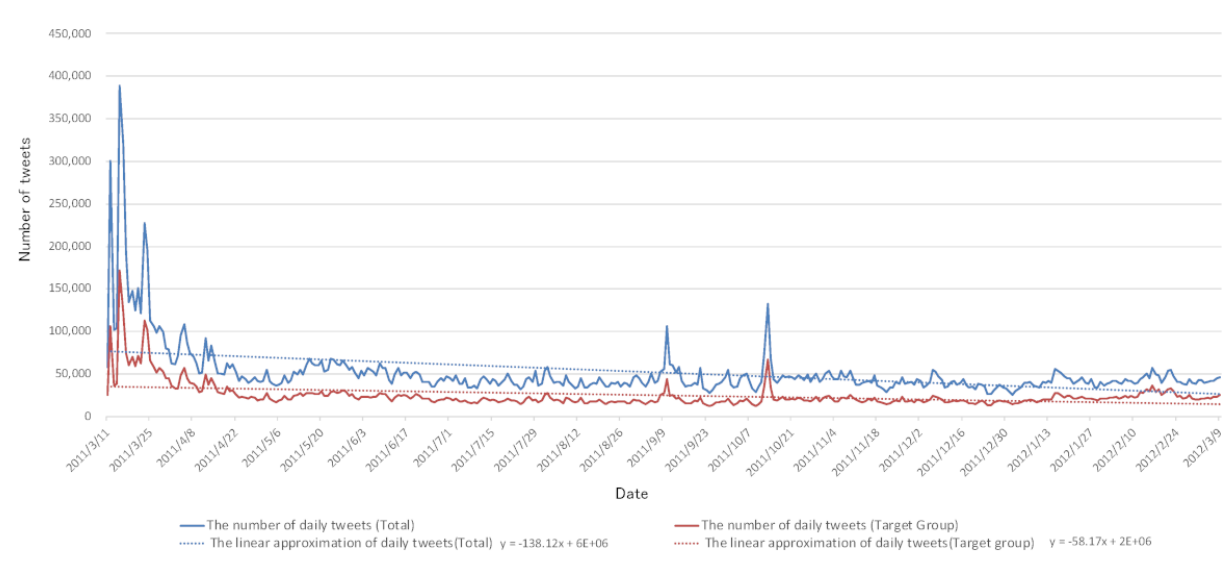
Figure 1. The number of tweets per day.